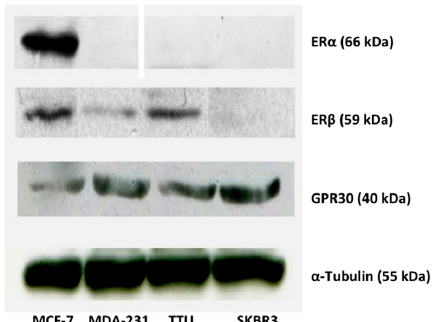
Figure 1. Protein expression levels for breast cancer cells demonstrating different ER